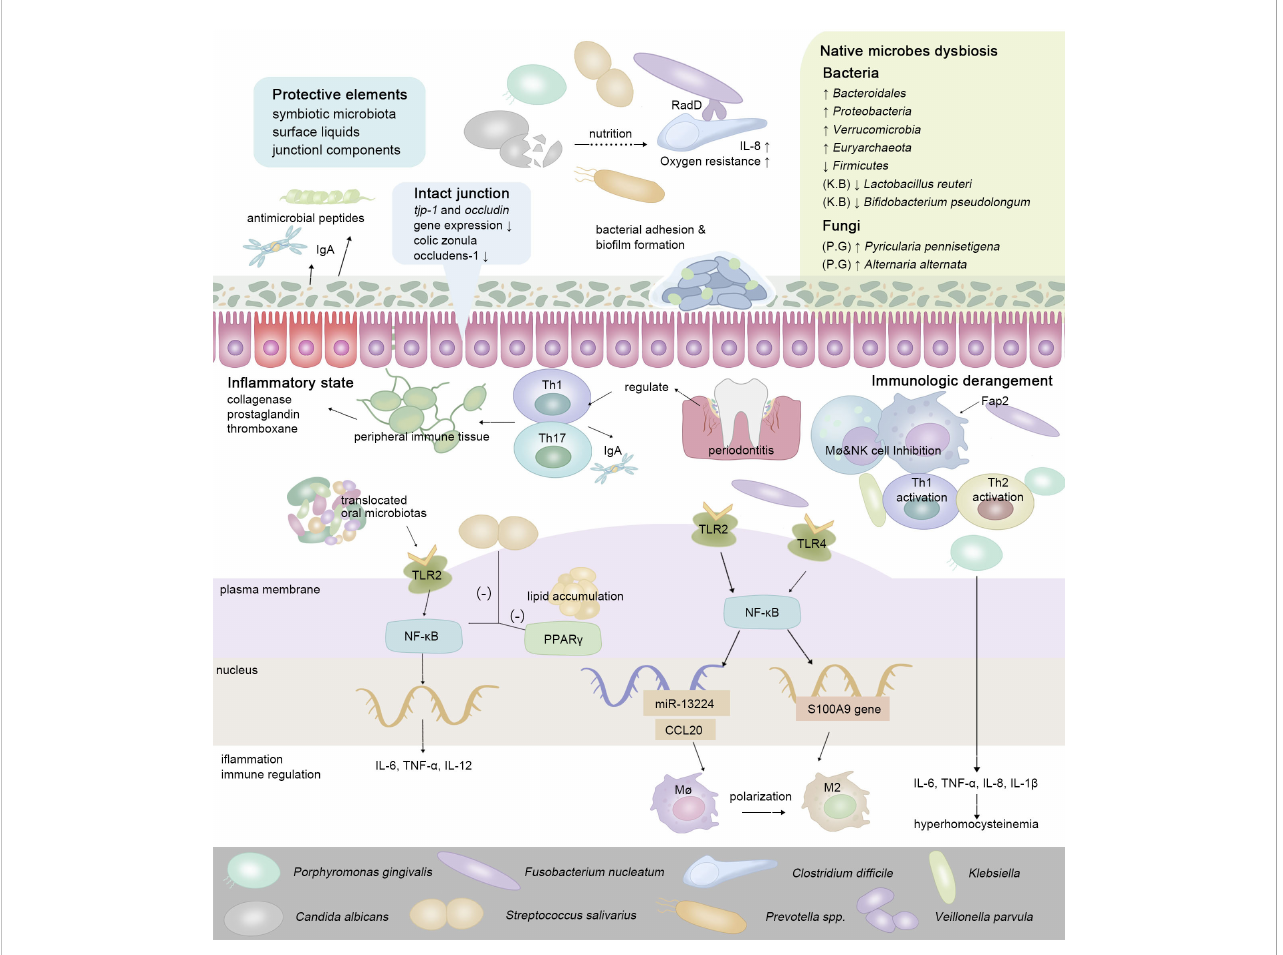
FIGURE 2 To maintain ecological balance, intestinal protective elements resist extra-intestinal microbes in the oral-derived microbiome dysbiosis. In the intestine, the enteral translocation of periodontopathic bacteria brings about gut microbiota dysbiosis and intestinal in fl ammation, thus weakening the intestinal surface liquids and junctional components (Nakajima et al., 2015; Feng et al., 2020). While interacting with the host ’ s immune system, via enteral route or hematogenous route, oral-derived pathogens regulate the constitution and transformation of immune cells, guiding the transition of the intestinal microenvironment from a healthy state to a pre-disease state. In regard to cell signaling pathways, cells of Paneth autonomously sense a series of oral metabolites via MyD88-dependent toll-like receptor (TLR), then stimulate antimicrobial cytokines and trigger the downstream NF-kB pathway, which subsequently regulates the production of a series of in fl ammatory cytokines (Vaishnava et al., 2008; Qi et al.,